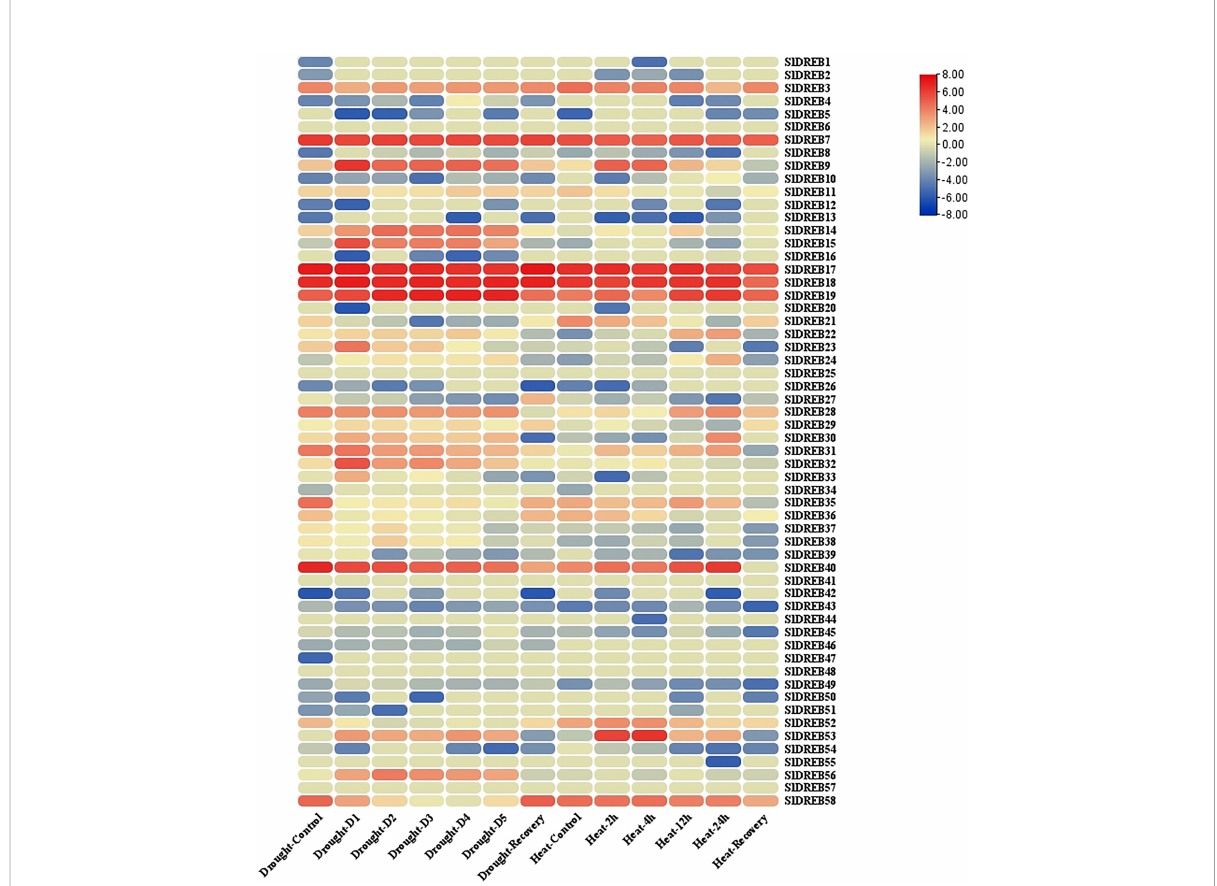
FIGURE 14 The expression analysis of 58 Sl DREB has been illustrated in the form of an expression heat map. Almost 29 Sl DREB genes were involved in response to drought and heat